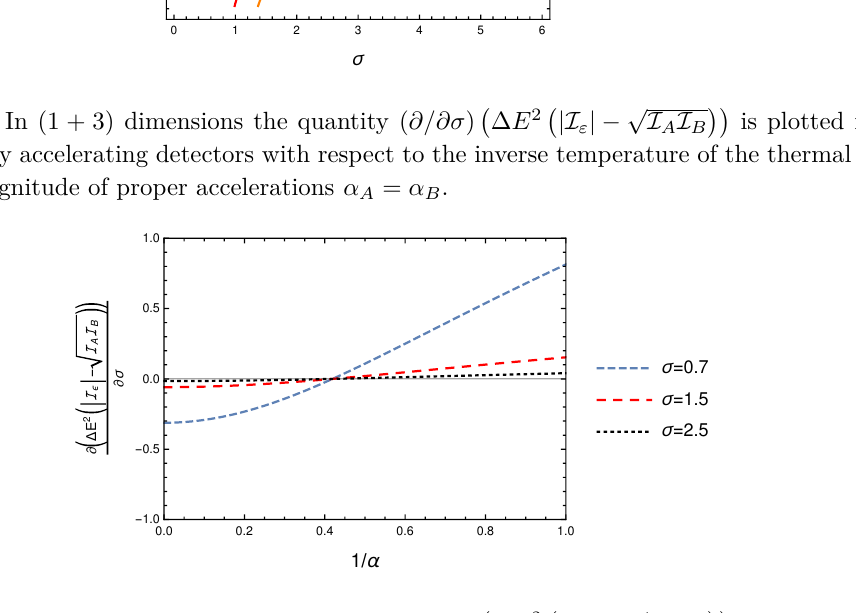
Figure 18 . In (1 + 3) dimensions the quantity ( ∂/∂σ ) anti-parallelly accelerating detectors with respect to the equal magnitude of proper accelerations α A = α B for fixed inverse temperature of the thermal bath σ